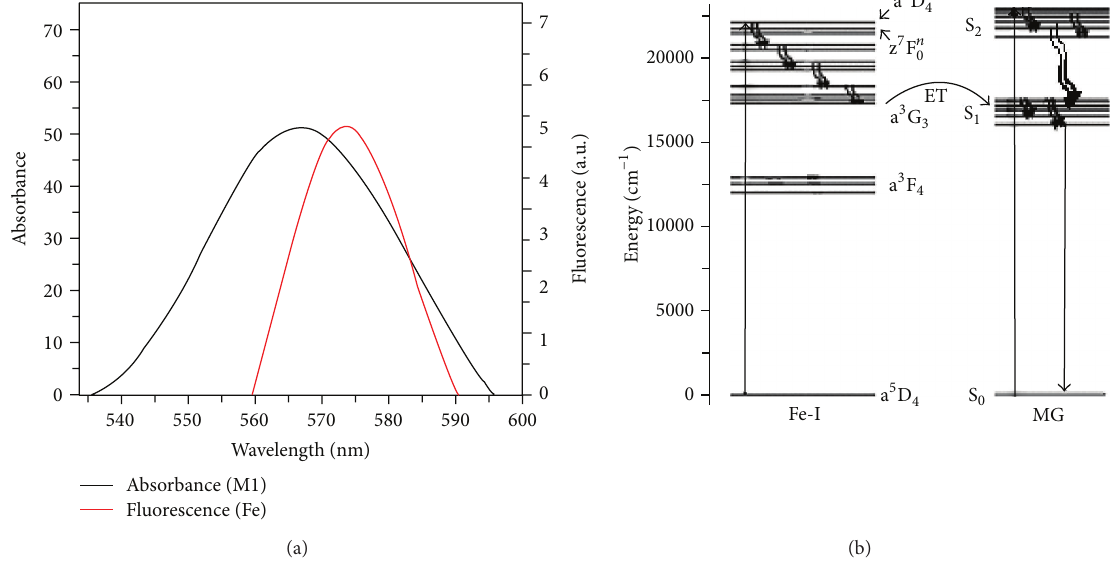
Figure 8: (a) Spectral overlap between a 5 P 3 → a 5 D 4 emission band of Fe-I and S 0 → S 1 MG absorbance band. (b) Schematic